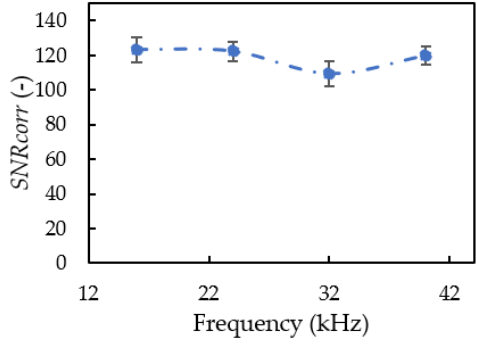
Figure 8. The effect of carrier wave changes to the noise tolerance. Figure 8. The e ff ect of carrier wave changes to the noise